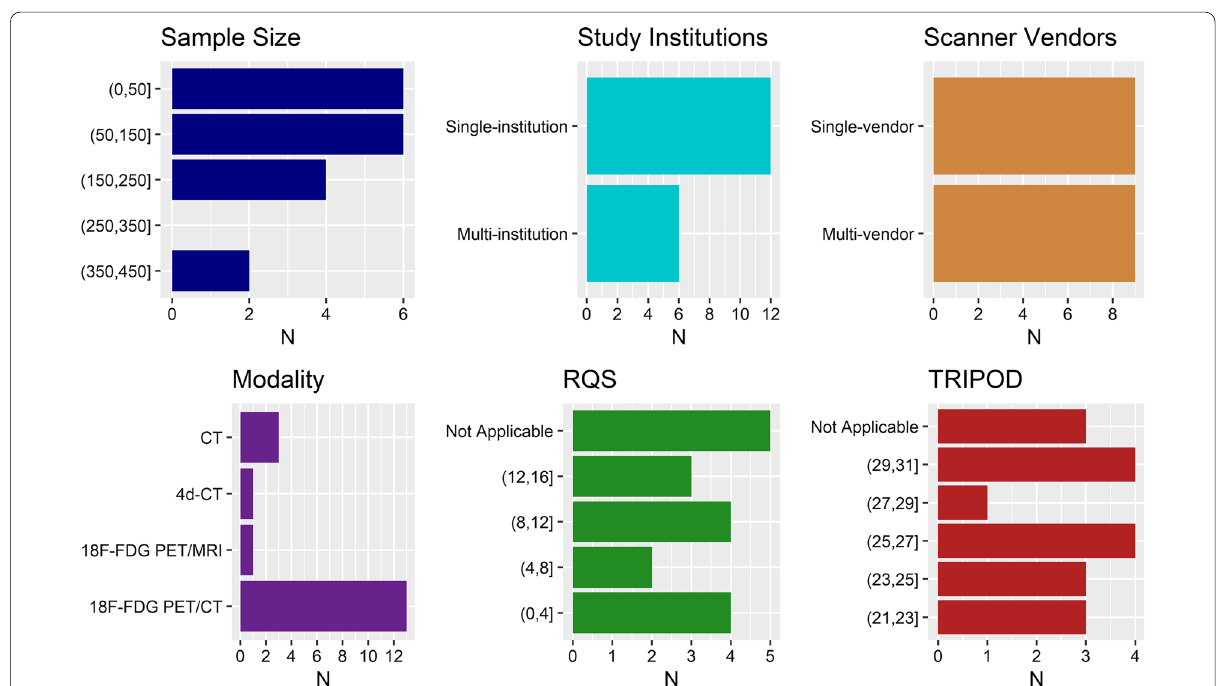
Fig. 2 Histograms of information on included articles. Upper left: study sample size. Upper middle: number of institutions from which data were collected. Upper right: number of scanner vendors with which images were acquired. Lower left: image modality. Lower middle: Radiomics Quality Score (RQS). Lower right: Transparent Reporting of a Multivariable Prediction Model for Individual Prognosis or Diagnosis (TRIPOD)